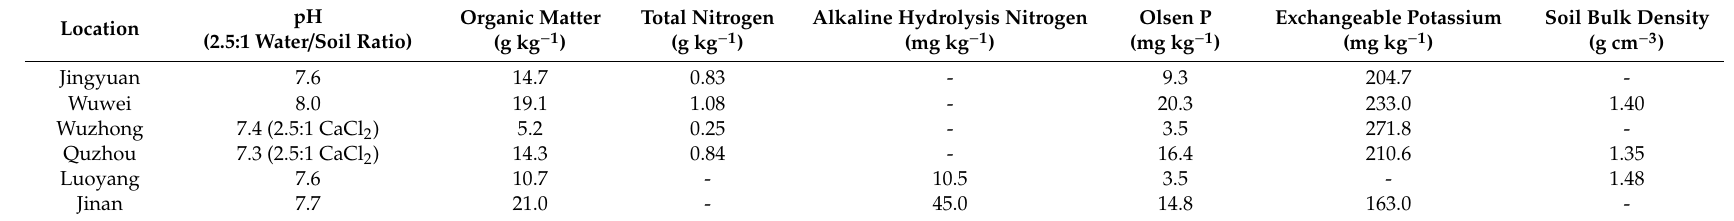
Table 2. Top soil (0–20 cm) basal properties before initiation of each experiment in di ff erent